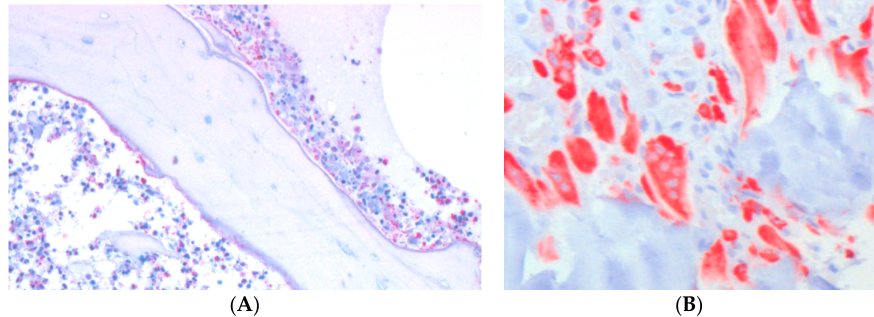
Figure 1. A dense infiltrate of neutrophils ( A ) can be detected in bone infections, as well as osteoclasts ( B ), red, after staining for cathepsin K.